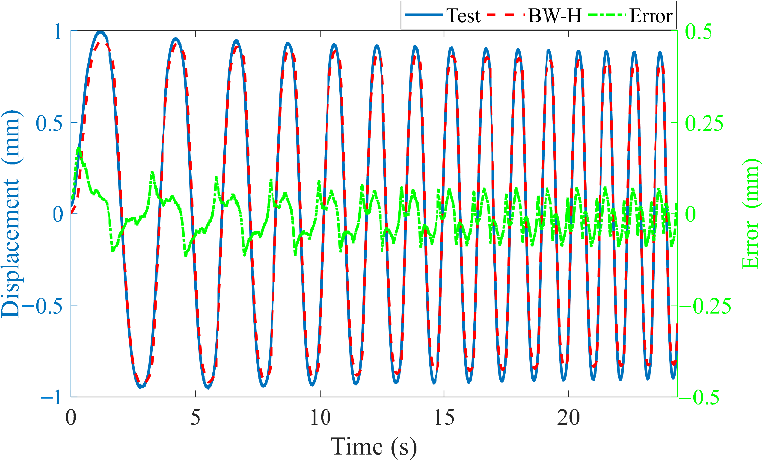
Figure 7. Predicated displacement of the BW-H model under chirp signal.